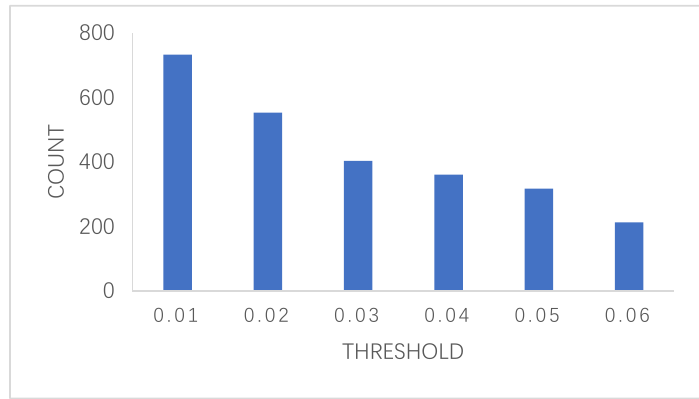
Figure 7. The number of EABMC frequent sequential patterns of datasets under minimum supports.